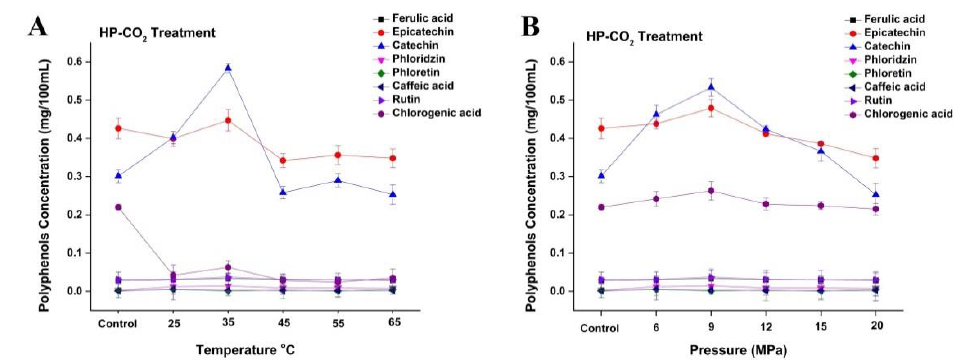
Figure 6. Changes in phenolic profile of apple juice subjected to di ff erent HP-CO 2 temperatures (25–65 ◦ C for 20 MPa) for 20 min ( A ) and di ff erent HP-CO 2 pressures (6–20 MPa at 30 ◦ C) for 20 min ( B ). Data presented as the mean ± SD (standard deviation).